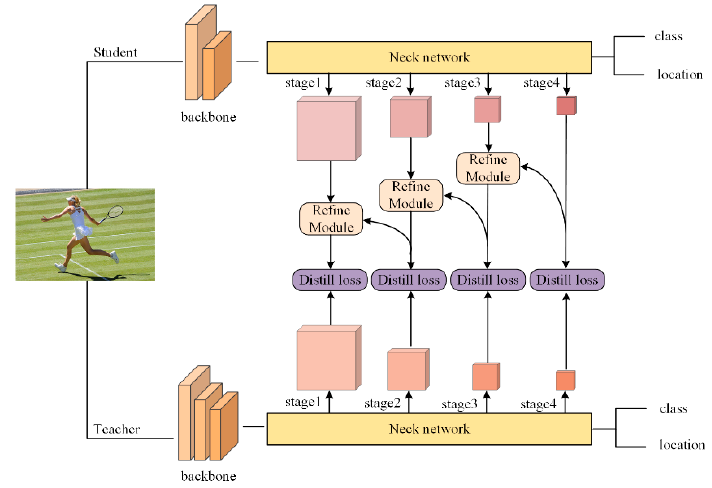
Figure 3. An illustration of the ICD method.